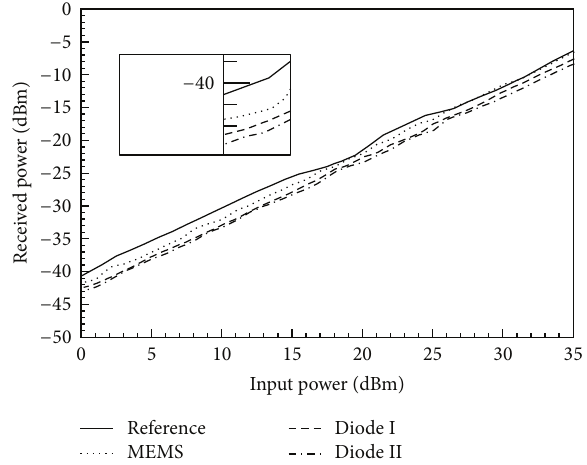
Figure 20: Comparison of the received power for the reconfigurable slot antenna with the RF switches in the far-field condition.